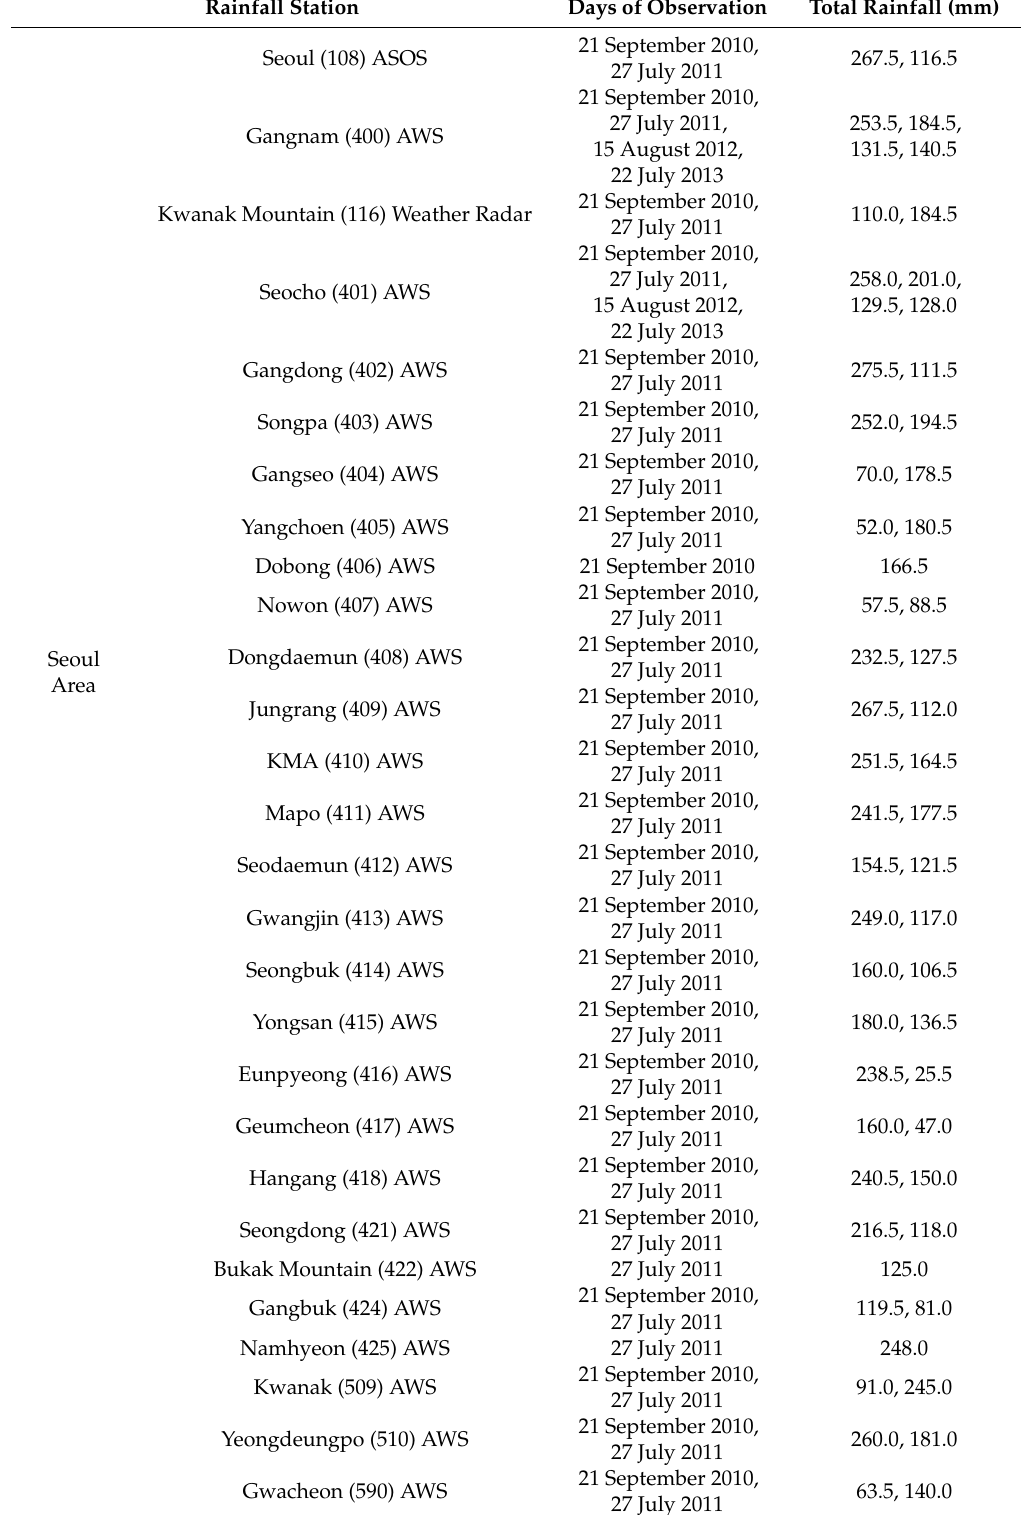
Table 1. Survey of observed rainfall